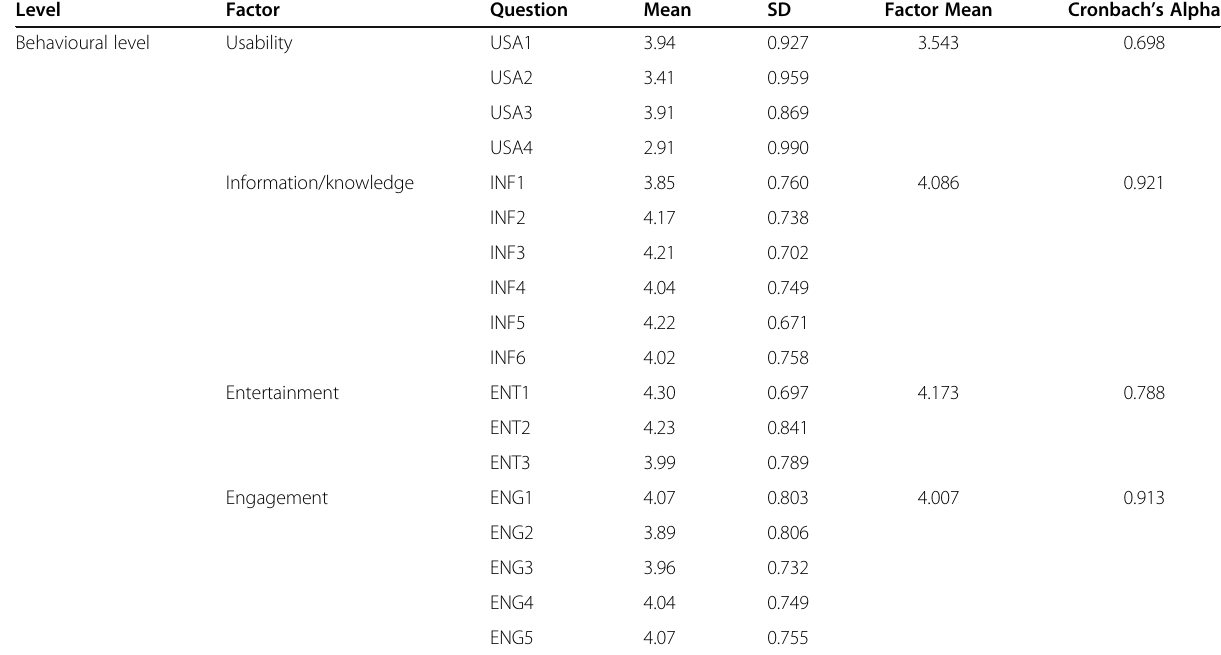
Table 3 Analysis results of the respondents ’ behavioural-level experience Level